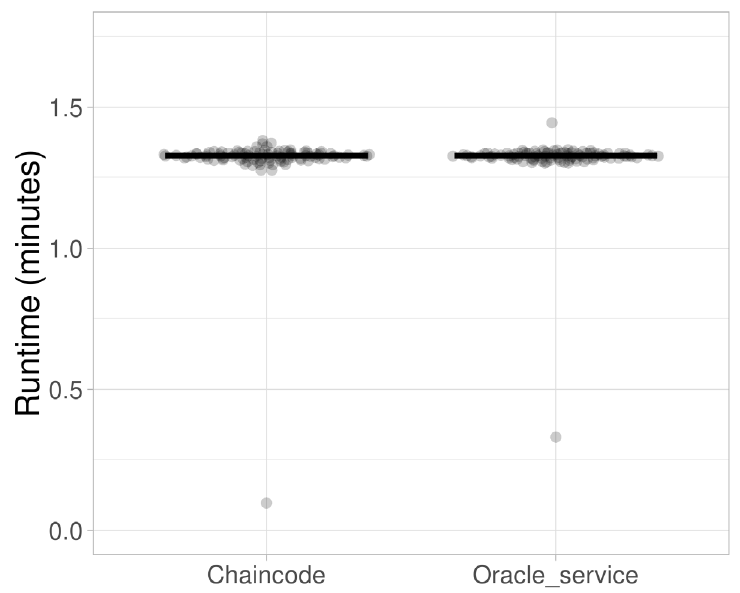
Figure 10. Distribution of runtime results using a network of 13 peers with the dataset of 32,768 records in the model validation experiment. The median runtime for model validation was 1 min 19 s for the chaincode ( left ) and 1 min 19 s for the oracle service ( right ). Table 3. Model inference overhead (in%) for the synthetic dataset, calculated as a median of 100 run- time ratios. The overall median from 3600 runs (6 × 6 × 100 runtime ratios) was 1.99% and the overhead was above zero for 69.15% of all